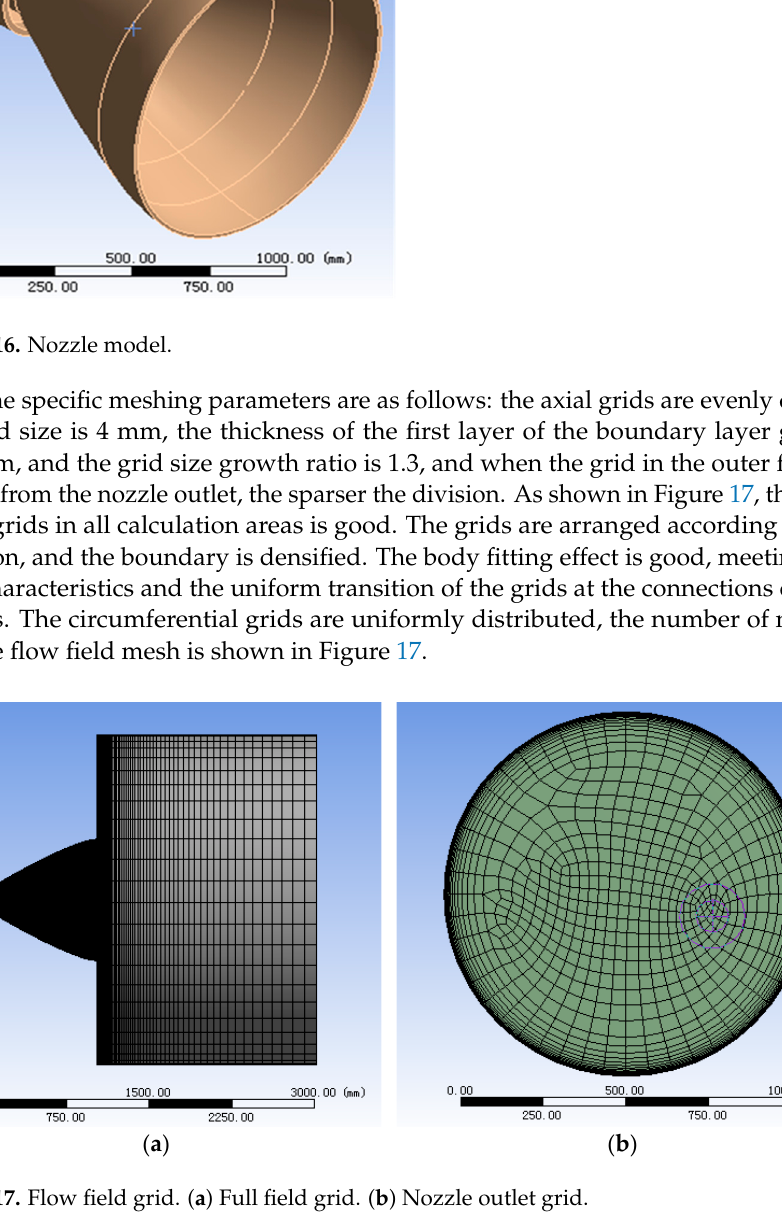
Figure 18. Nozzle structural grid. The actual structure of the nozzle is composed of a variety of composite materials. The materials are anisotropic. The performance of the nozzle in all directions is related to the nozzle design and winding process. The interaction between different materials is very complex, so it is difficult to calculate in practice. In order to reflect the main problems, the structure of the nozzle was simplified in the calculation, and the nozzle was considered to be composed of a single isotropic composite material. The main parameters of the ma- terial are ρ = 1550 kg/m 3 , Poisson ratio γ = 0.2, and elastic modulus E = 1.5 × 10 4 MPa. In the flow field calculation, the gas in the nozzle was treated as follows: the density was treated as an ideal gas; the constant pressure specific heat capacity and molecular weight were fixed values, respectively; the constant pressure specific heat C p was equal to 4155 J/kg·K; the average molecular weight M was equal to 28.75 g/mol; and the viscosity coefficient followed Sutherland’s three-coefficient formula. The gas material parameters were set in Fluent, and the chemical reactions and two-phase flow were not considered in the calculation process. For this large expansion ratio Laval nozzle, when the engine is working at a high altitude and in an accelerated state, the pressure in the nozzle decreases, the temperature decreases, and the gas expands and accelerates. In the accelerated state, the process of heat exchange between the wall and the external gas is instantaneous, so the wall can be